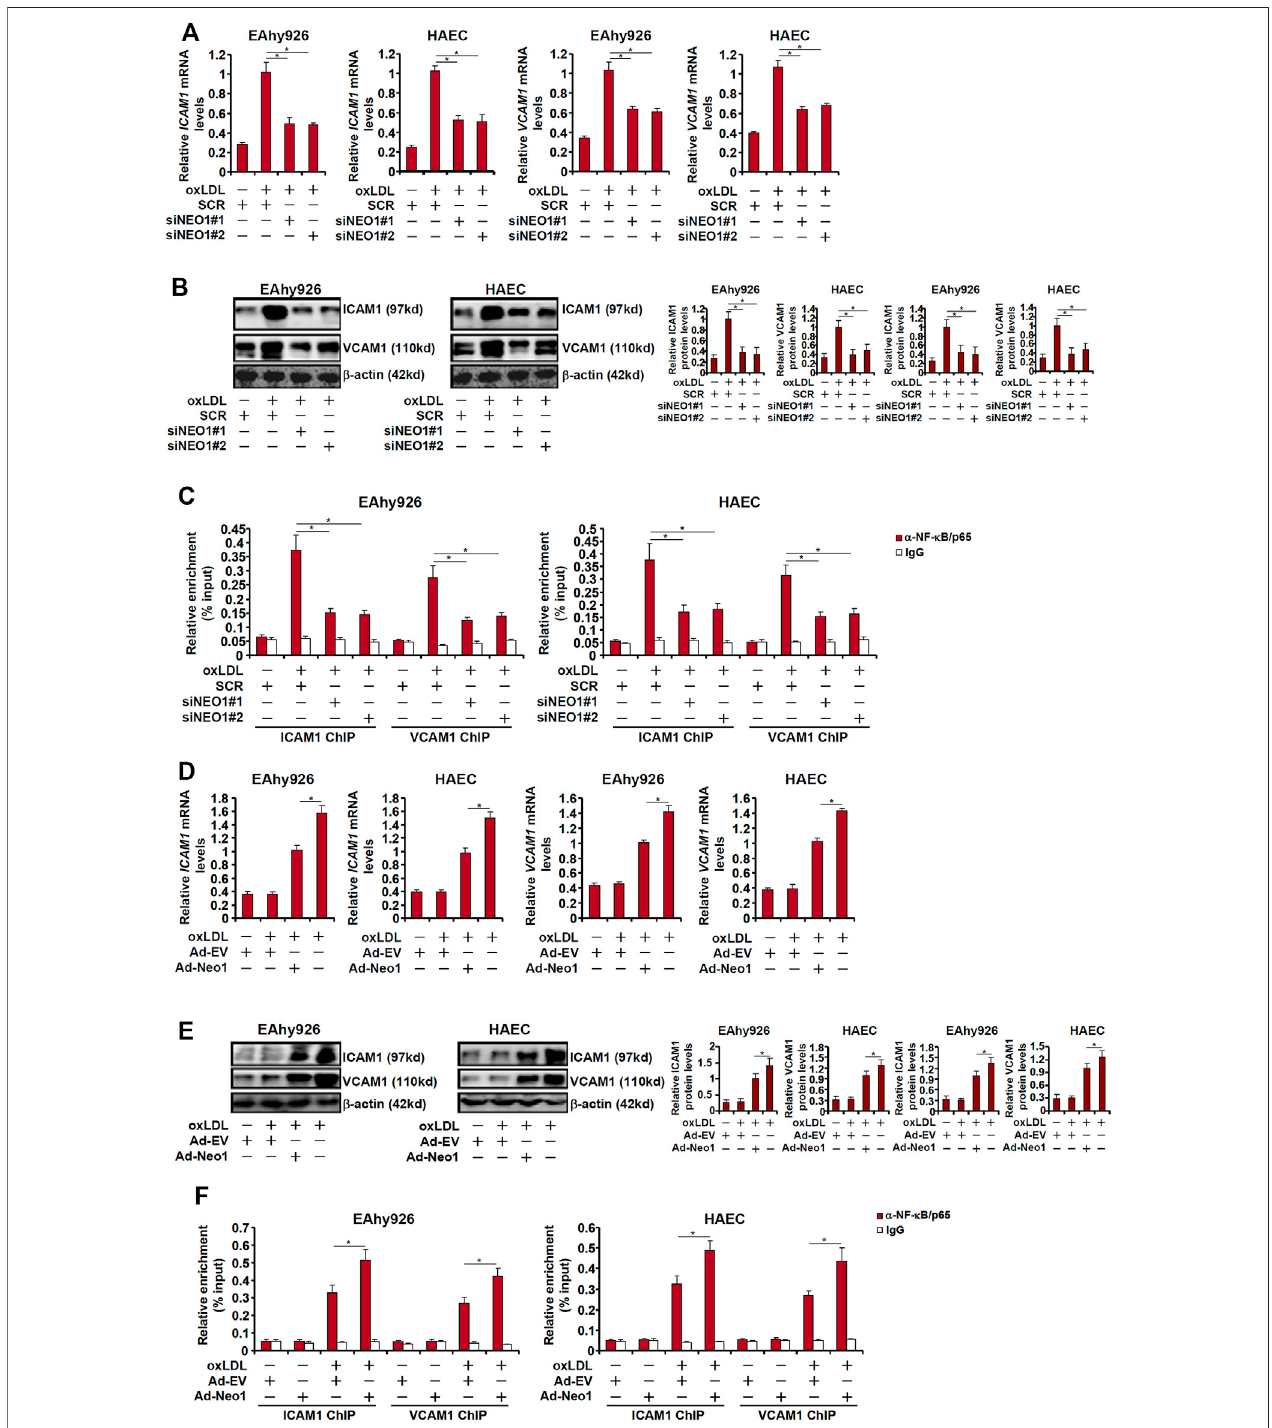
FIGURE 3 | Neo-1 regulates expression of adhesion molecules by modulating NF- κ B activity. (A – C) EAhy926 cells and HAECs were transfected with indicated siRNAsfollowedbytreatmentwithoxLDL(50 μ g/ml)for24 h.ExpressionlevelsofadhesionmoleculeswereexaminedbyqPCRandWesternblotting.ChIPassayswere performed with anti-NF- κ B or IgG. (D – F) EAhy926 cells and HAECs were transduced with adenovirus carrying a Neo-1 vector (Ad-Neo1) or control adenovirus (Ad-EV) followed by treatment with oxLDL (50 μ g/ml) for 24 h. Expression levels of adhesion molecules were examined by qPCR and Western blotting. ChIP assays were performed with anti-NF- κ B or IgG.